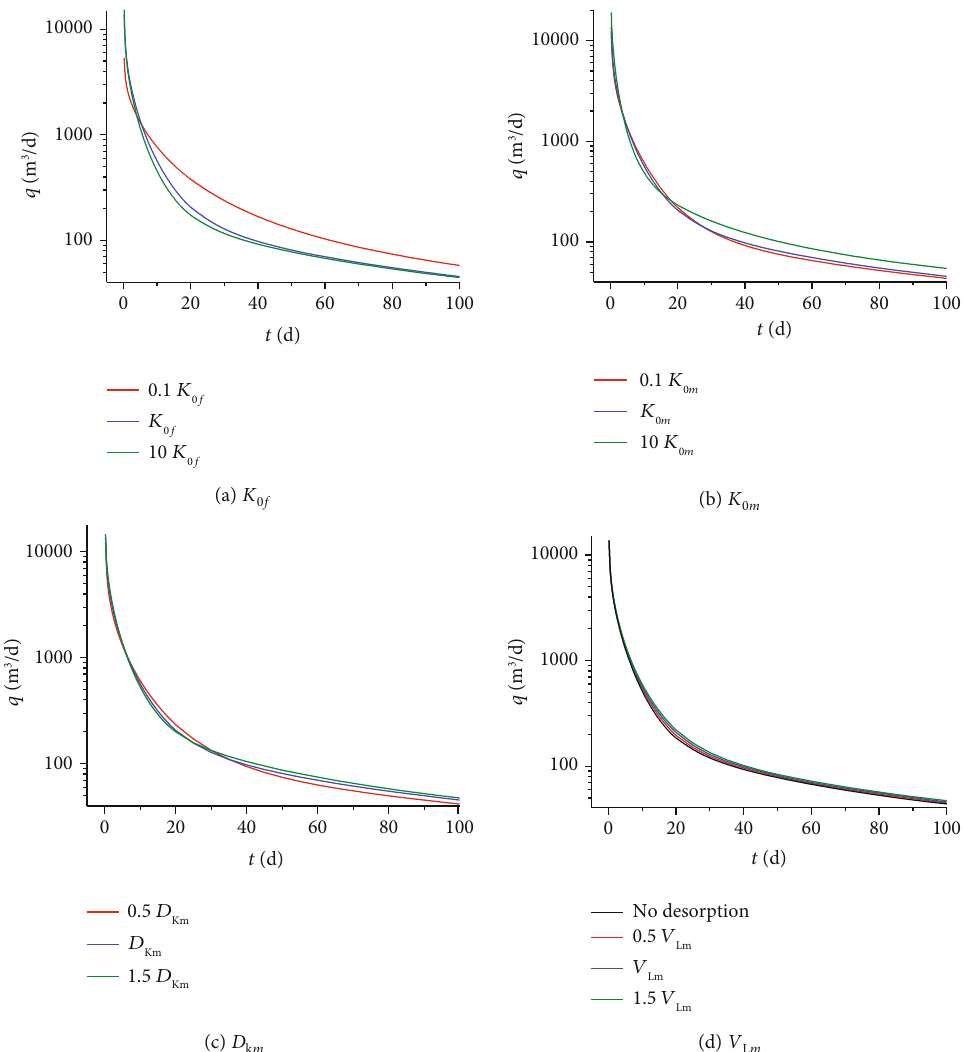
Figure 11: Change in daily production with di ff erent parameters of the lattice-like